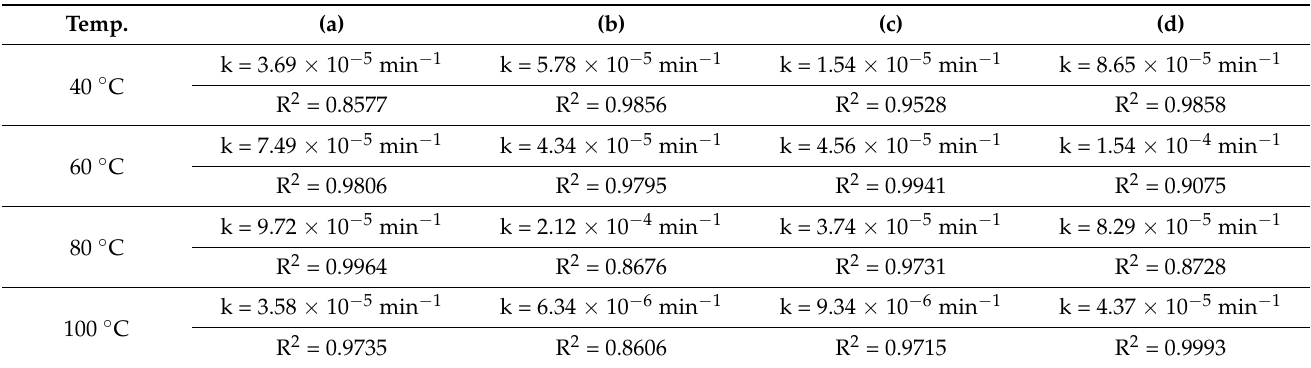
Table 3. Reaction rate constant and confidence value of the linear approximation from Figure 3. Temp.